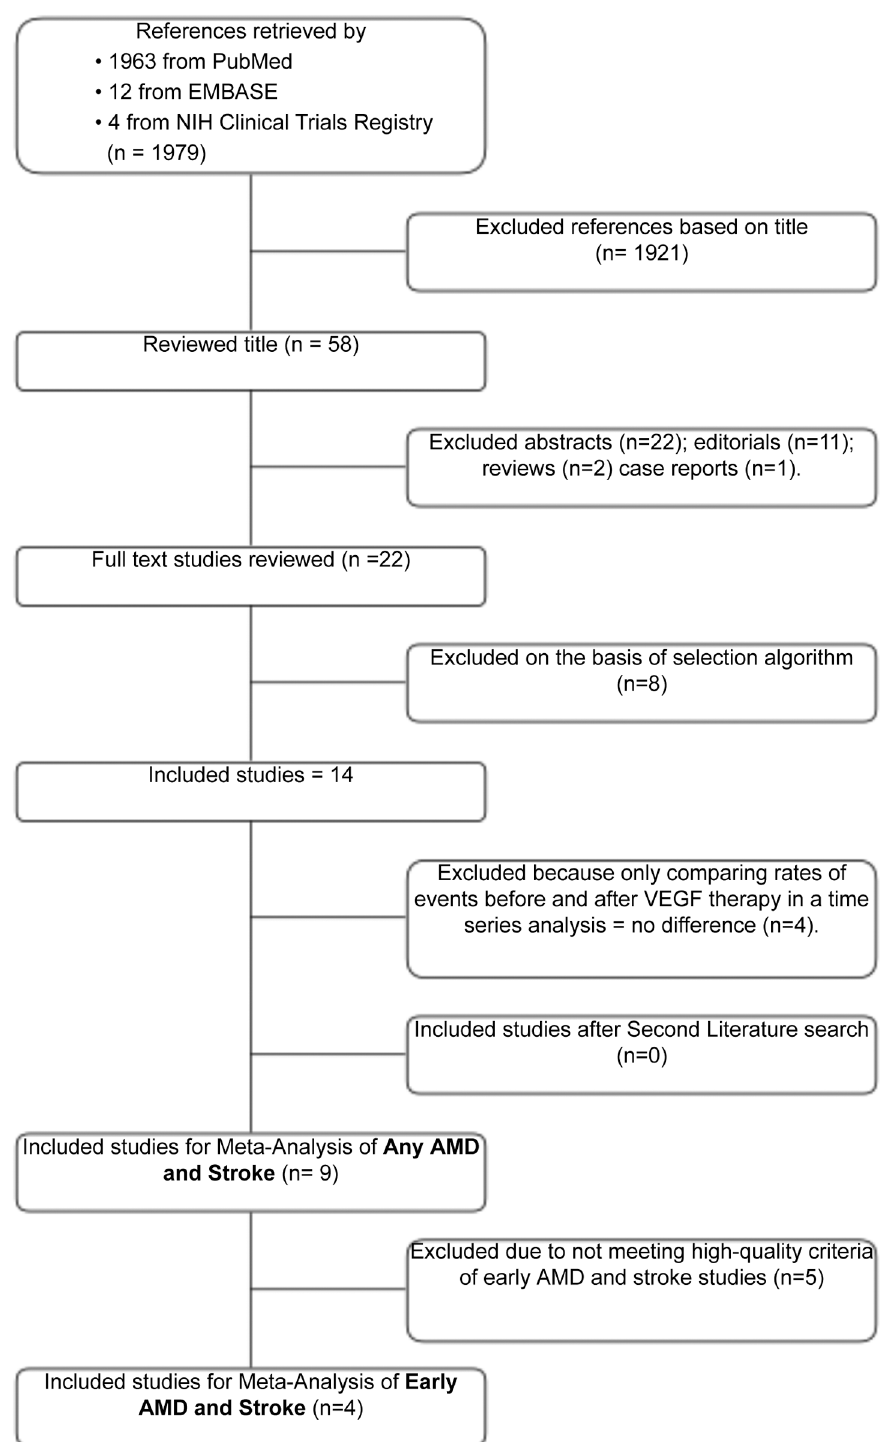
Fig 1. Flowchart of Article Selection for Meta-analysis of AMD and Stroke. Potentially relevant references identified and screened for retrieval. AMD, Age-related Macular degeneration; VEGF, Vascular endothelial growth